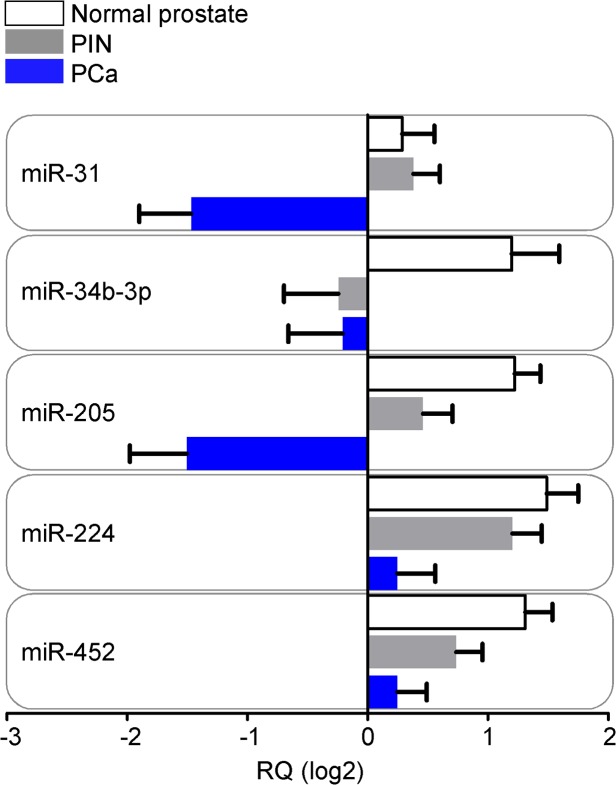
miRNA expression in human prostate tissues.Matched normal prostatic glands, prostatic intraepithelial neoplasia (PIN) and prostate cancer (PCa) lesions available from 50 patients were tested for expression levels of the eighteen selected miRNAs. MiR-31, 34b-3p, 205, 224 and miR-452 displayed significantly altered levels between the three tissue classes (p<0.01 by Friedman test). Bars, mean±SEM. RQ, relative miRNA quantity.